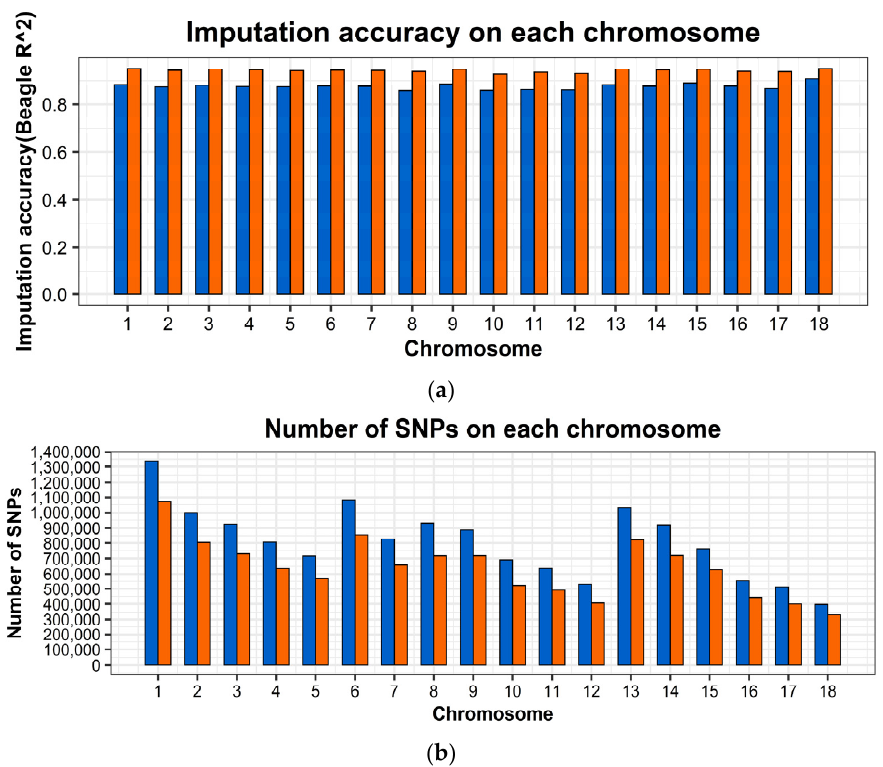
Figure 1. The summary of imputation accuracy and number of SNPs after imputation from 50K chip data to WGS data. ( a ) Imputation accuracy in each chromosome in Large White pigs. Imputation accuracy before quality control (blue), after quality control, with R 2 > 0.8 (orange). ( b ) Number of SNPs after imputation with or without quality control in each chromosome in Large White pigs. Number of SNPs before quality control (blue), Number of SNPs after quality control (orange).